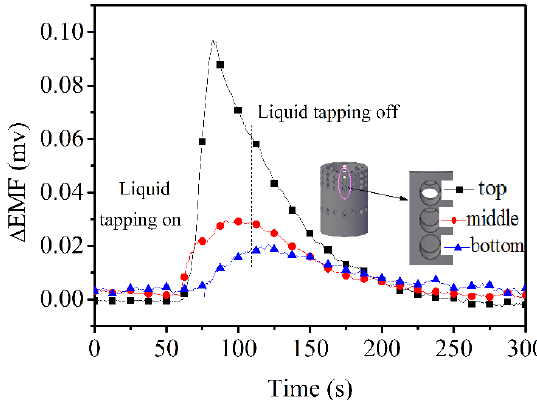
Figure 11. EMF signals of molten tin from inner wall.